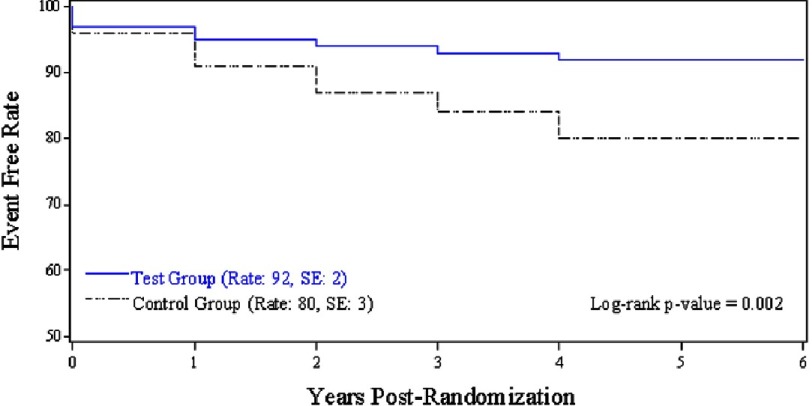
Five-year freedom from major or minor bleeding events in the test group (blue) versus the standard group (black) in the PROACT trial (from Puskas et al.8).